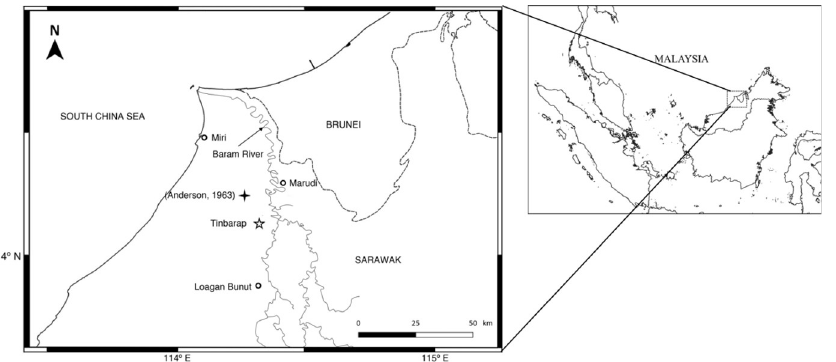
Fig 1. Map of the studied site of Borneo tropical peatland. A peat core was collected at the Tinbarap site (N 04˚ 03’01.47” E 114˚15’02.45”), which was marked as ☆ . A previous study was conducted by Anderson [29] (marked by ) on the vegetation composition of the Borneo peat dome. The map was made using QG is software (version 3.6.2).